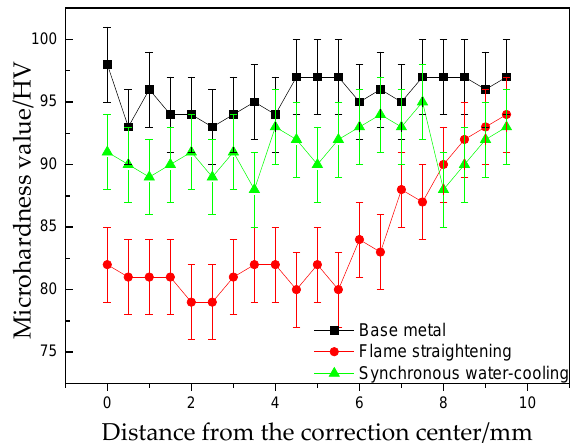
Figure 10. Microhardness profiles of specimens and base metal.